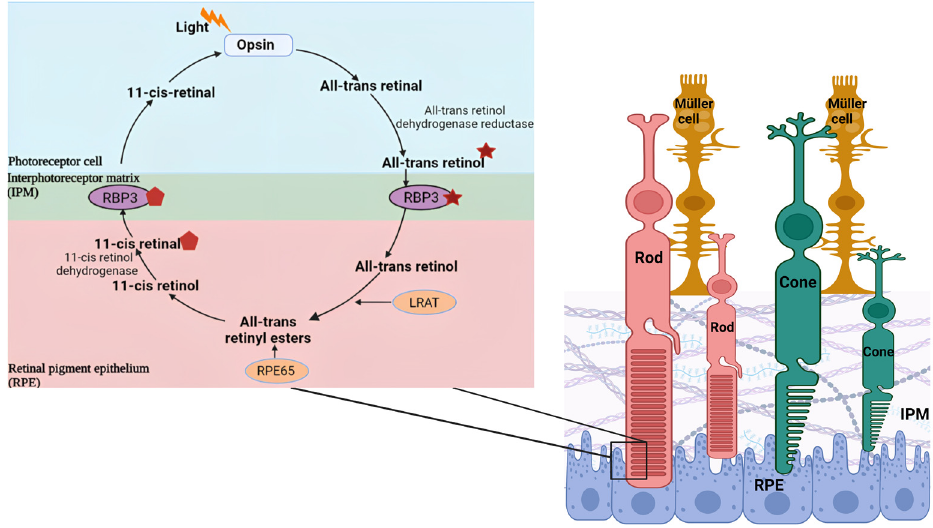
Figure 2. Simplified composition of the retina with RPE, photoreceptors, Muller cells, and IPM represented. Insert: Visual cycle.